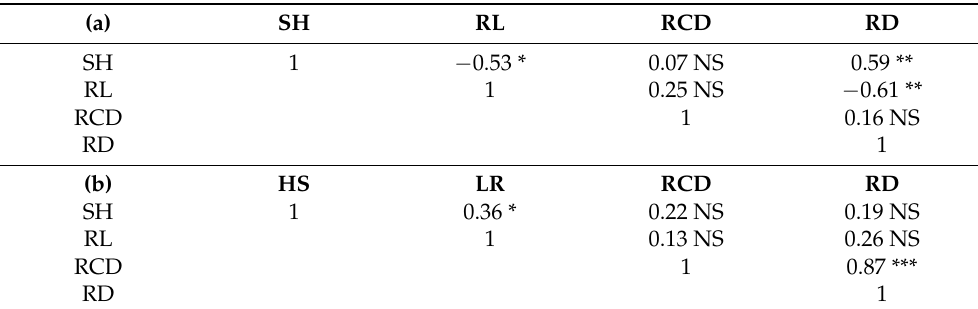
Table 3. Pearson correlation (r) between growth variables for early (a) and late (b) successional species, two years after